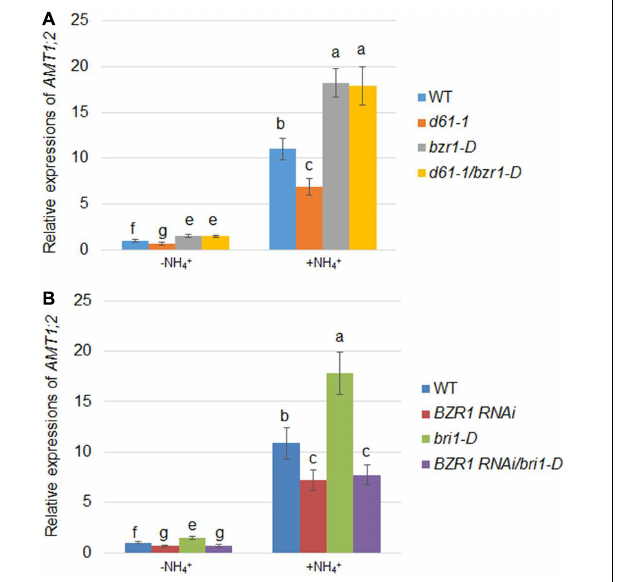
FIGURE 5 | BR-induced AMT1;2 expression in the genetic combinations between BZR1 and BRI1 . (A) The expression levels of AMT1;2 genes in wild-type, BRI1 mutant d61-1 , gain-of-function mutant bzr1-D , and their cross offspring d61-1 / bzr1-D before and 3 h after BL treatment. (B) The expression levels of AMT1;2 genes in the wild-type, BZR1 RNAi , BRI1 overexpression line bri1-D , and their cross offspring BZR1 RNAi/bri1-D before and 3 h after BL treatment. The above plants were grown in distilled water for 7 days with or without treatment of 100 nM BL for 3 h. The expression levels of AMT1;2 genes were measured by qRT-PCR. Sample mRNA levels were normalized to those of Ubiquitin . Data represent means ± SE ( n = 3). The experiments were repeated at least three times. Different letters represent statistically significant differences ( P < 0.05).